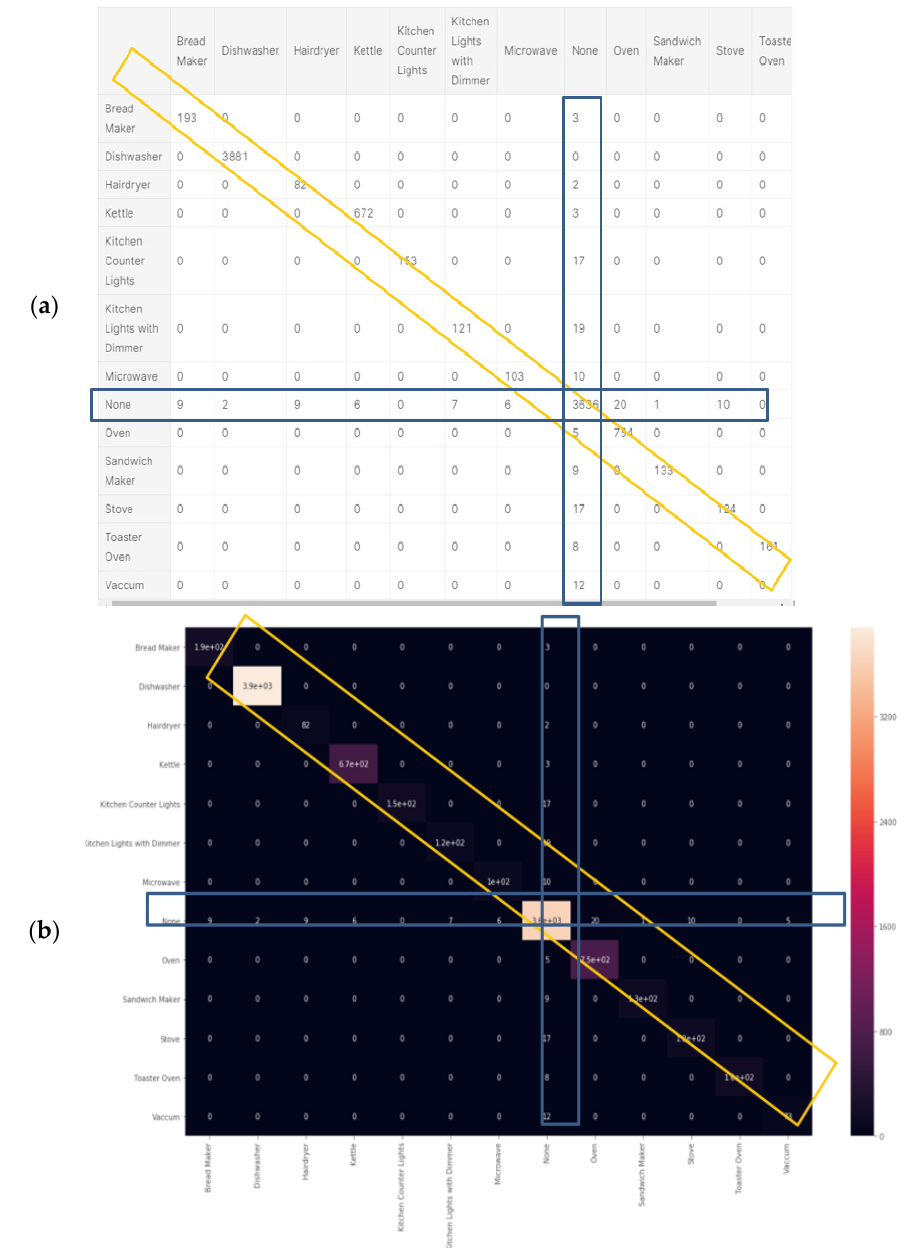
Figure 15. Random forest classifier ( a ) confusion matrix and ( b ) Pearson’s correlation heatmap. There are differences from the KNN and Ridge. Relatively less accurately